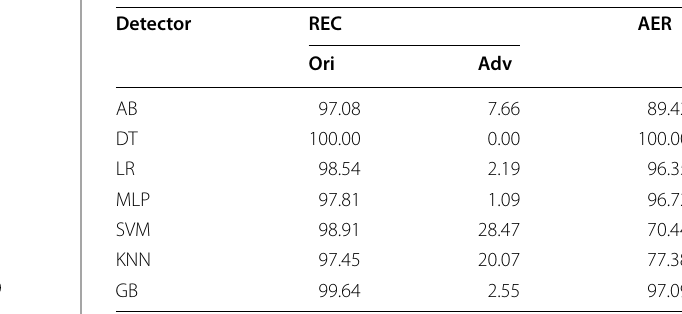
Table 6 The performance of the LSGAN module (%)